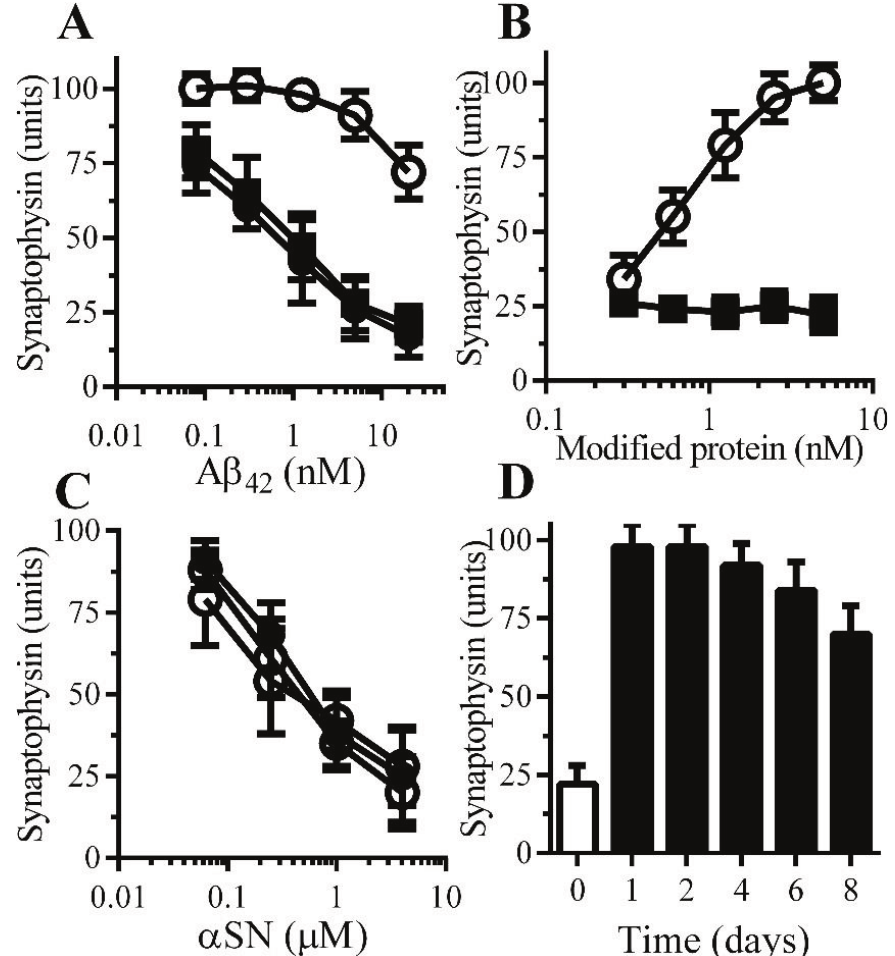
Figure 4. Monoacylated PrP C pr otected neurons against Aβ -induced synapse damage: ( A )